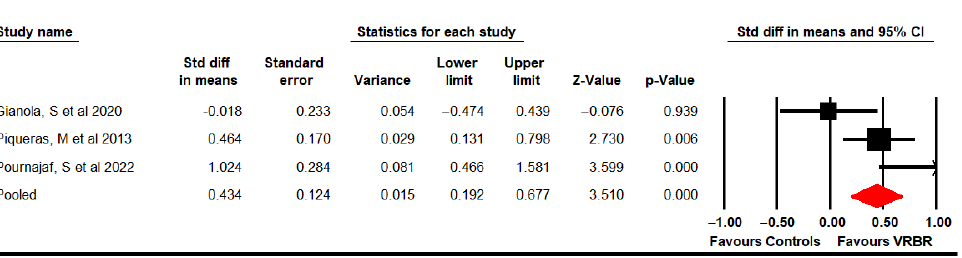
Figure 6. Forest plot of the immediate effect of VRBR on quadriceps strength [65,68,69].